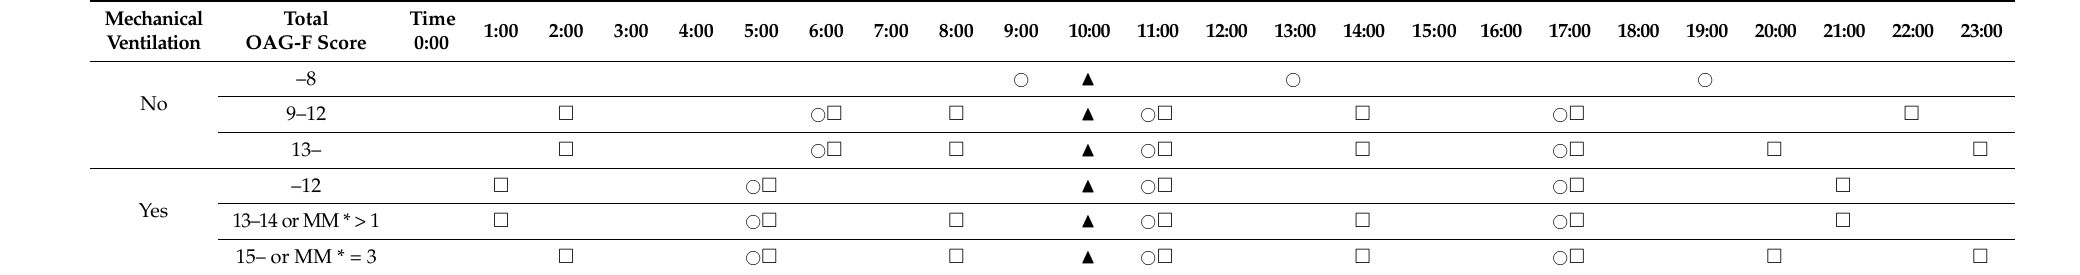
Table 2. Timetable of the oral assessments and oral